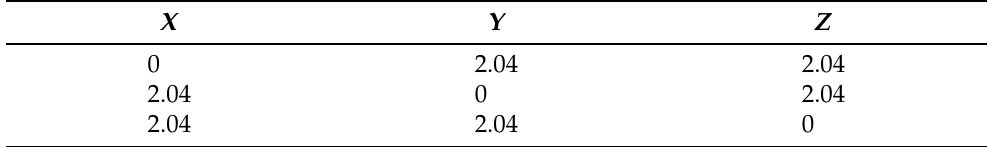
Table A2. FCC Ag (single atom at origin)